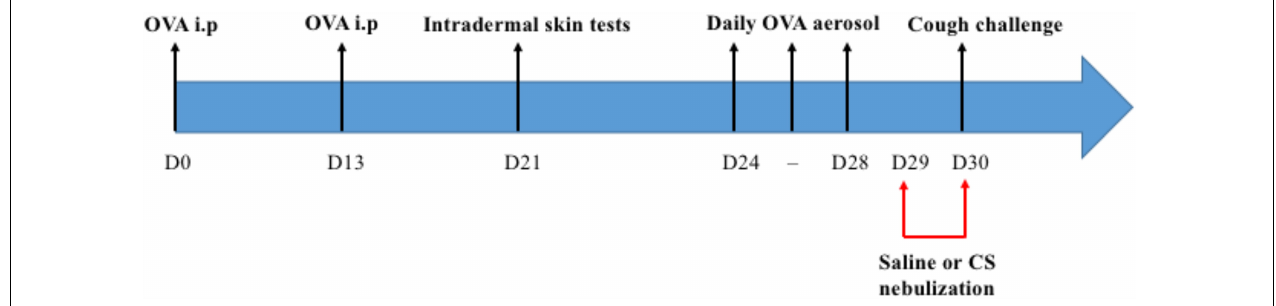
FIGURE 1 | Pre-experimental interventions. Each rabbit received intraperitoneal (i.p) injections of ovalbumin (OVA), an intradermal skin test and a daily aerosol of OVA for 3 consecutive days between D24 and D28. They were challenged with saline or corticosteroid (CS) nebulizations at D29 and